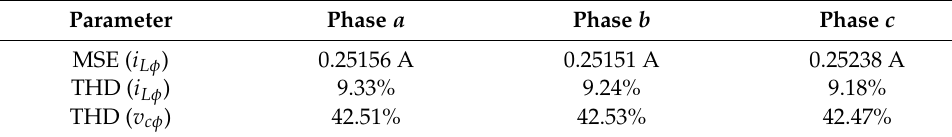
Table 10. Simulation results for FCS-MPC in the presence of parametric uncertainties.